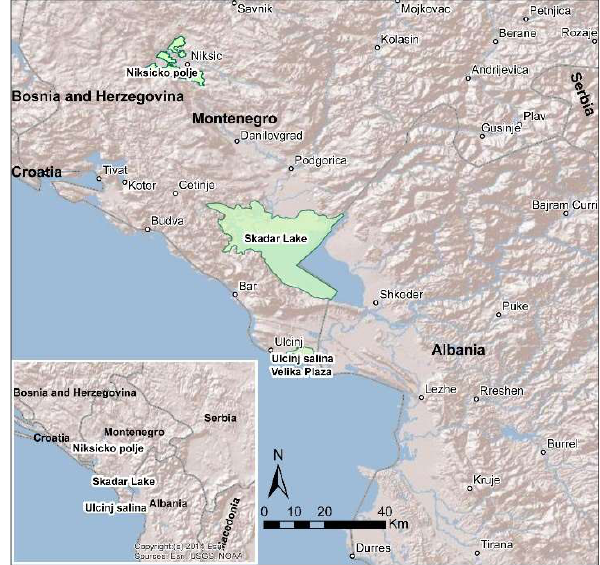
Figure 1. The selected sites in the Montenegro – Albania